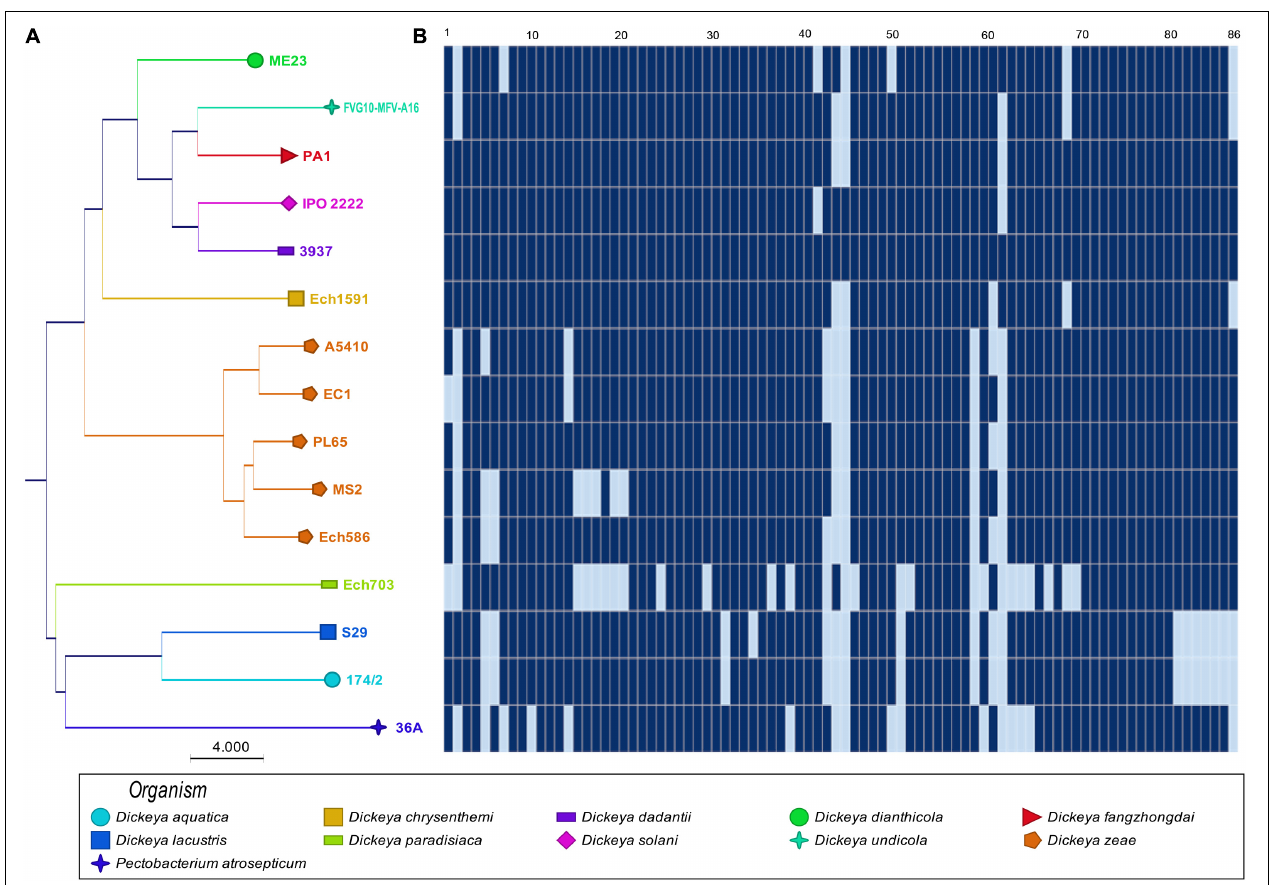
FIGURE 2 | Sharing of plant cell wall-degrading enzymes (PCWDEs) in Dickeya species. The types of cell wall-degrading enzymes are indicated for each of the strains. (A) Concatenated Neighbor-Joining phylogenetic dendrogram based on 86 PCWDEs in Dickeya sp. The Neighbor-Joining method was applied to determine the distances, with each node being supported by a bootstrap of 1,000 replicates to assess reliability. (B) Color scales based on the presence and absence of 86 plant cell wall-degrading genes in the genomes. Dark blue ( ) shows the presence of genes, and light blue ( ) shows the absence of genes. In (B) , numbers 1–86 are described in Supplementary Table 1